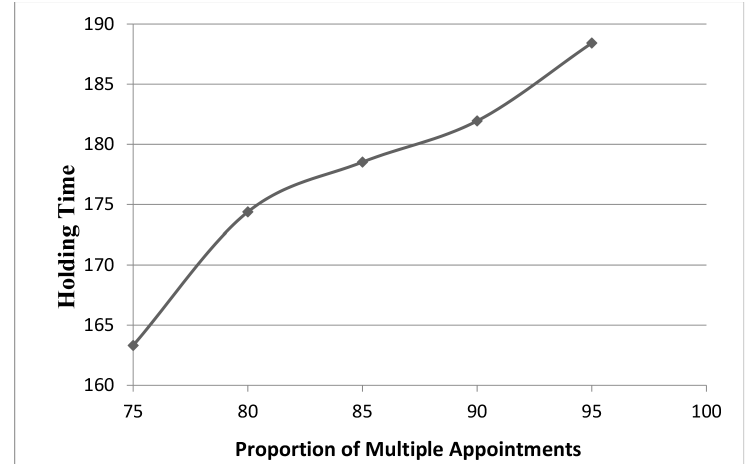
Figure 5. Impact of proportion of multiple appointments on holding time